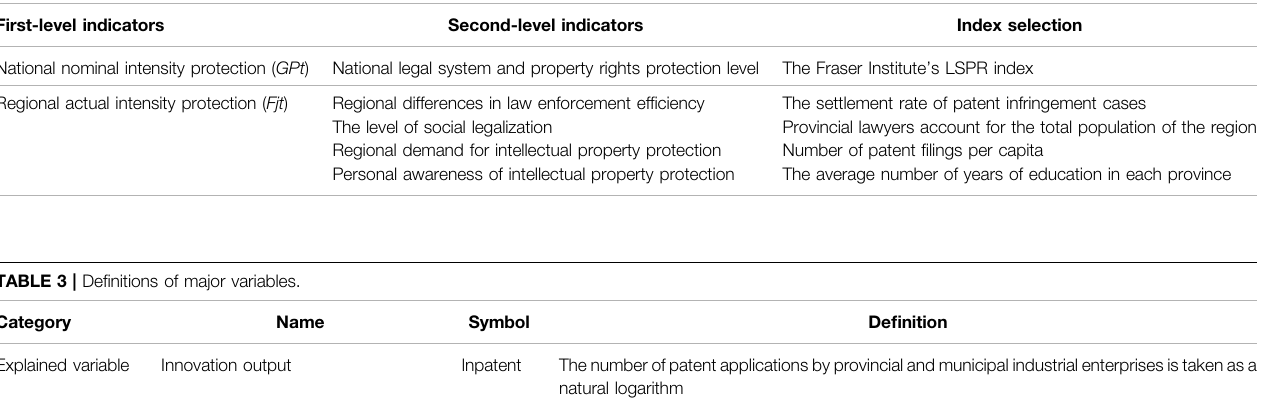
TABLE 2 | Indicators of intellectual property protection intensity.